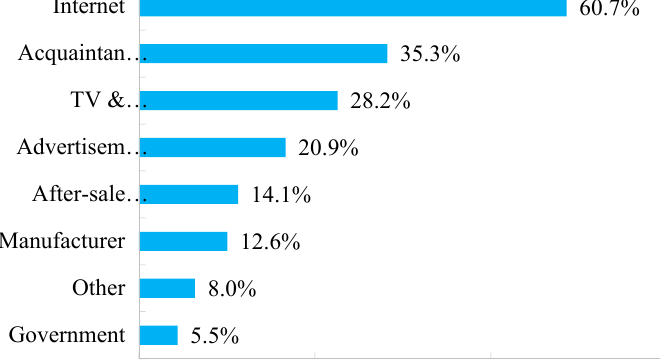
Figure 2. Information channels of remanufactured products.